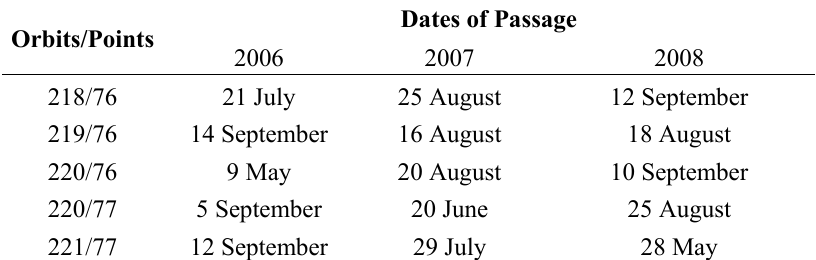
Table 1. Path/row and dates of passage of the Landsat/TM5